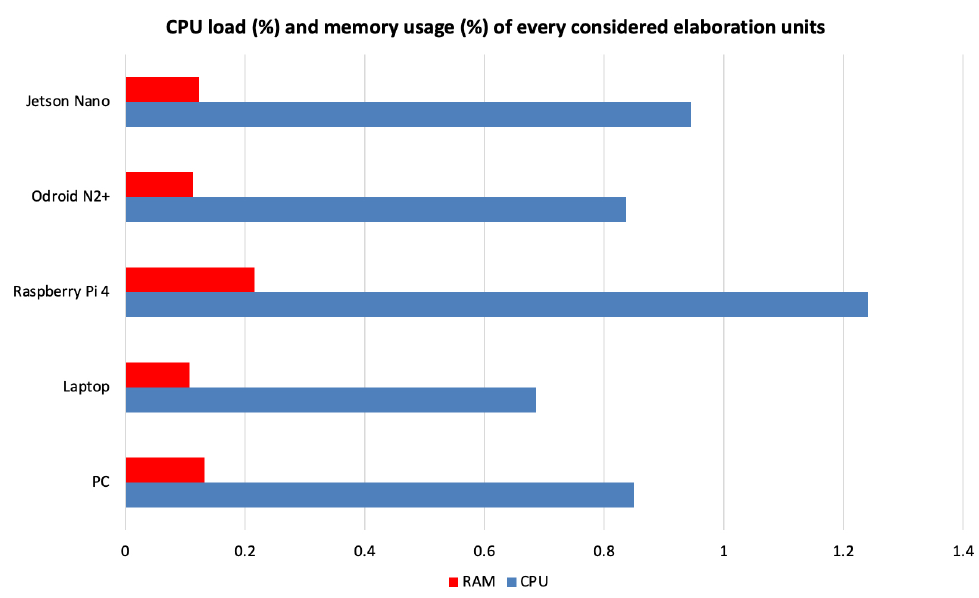
Figure 7. CPU load (%) and memory usage (%) of the five considered elaboration